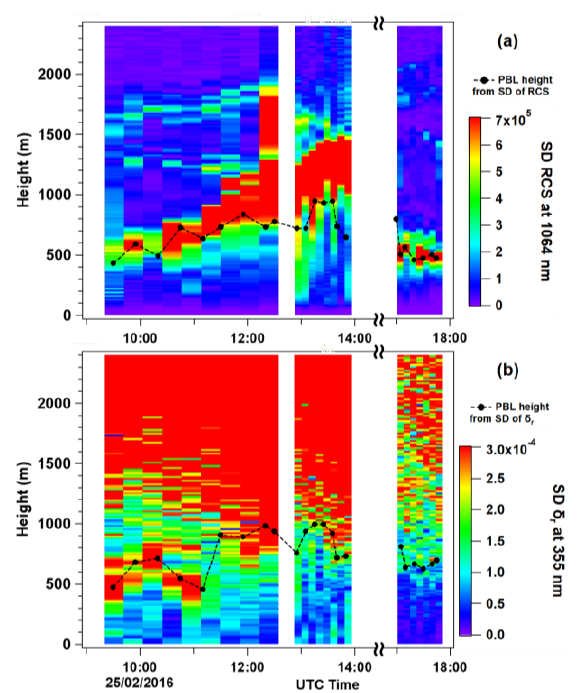
Figure 2 Color plot of the temporal evolution of the standard deviation (SD) of (a) the range corrected lidar signal (RCS) at 1064 nm and (b) the linear volume depolarization ratio (  r ) at 355 nm on 25 February 2016. Black dots identify the determined PBL heights.